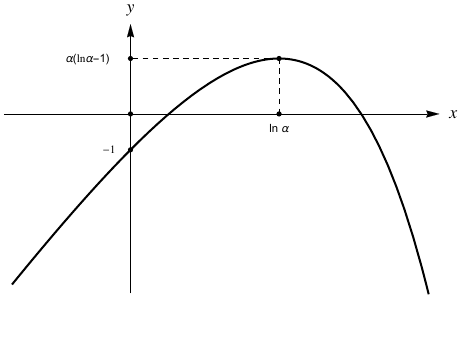
Figure 5. Plot of f ( y ) = α y − e y